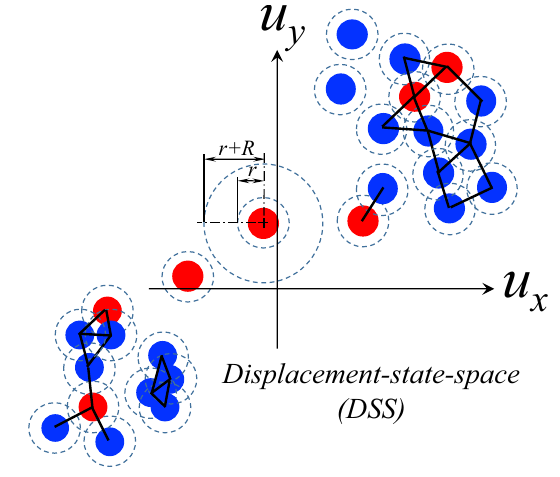
Figure 2. Schematic plot of the method for constructing G ( r ) for N = 27 nodes. Each node is located at its corresponding grain displacement vector ( u x , u y ). For a given radius r , two nodes within a distance r (radius of dashed circle) in DSS are connected by a link. Red nodes act as a bridge between the two largest com- munities of sizes 10 (top-right) and 7 (bottom-left), respectively.